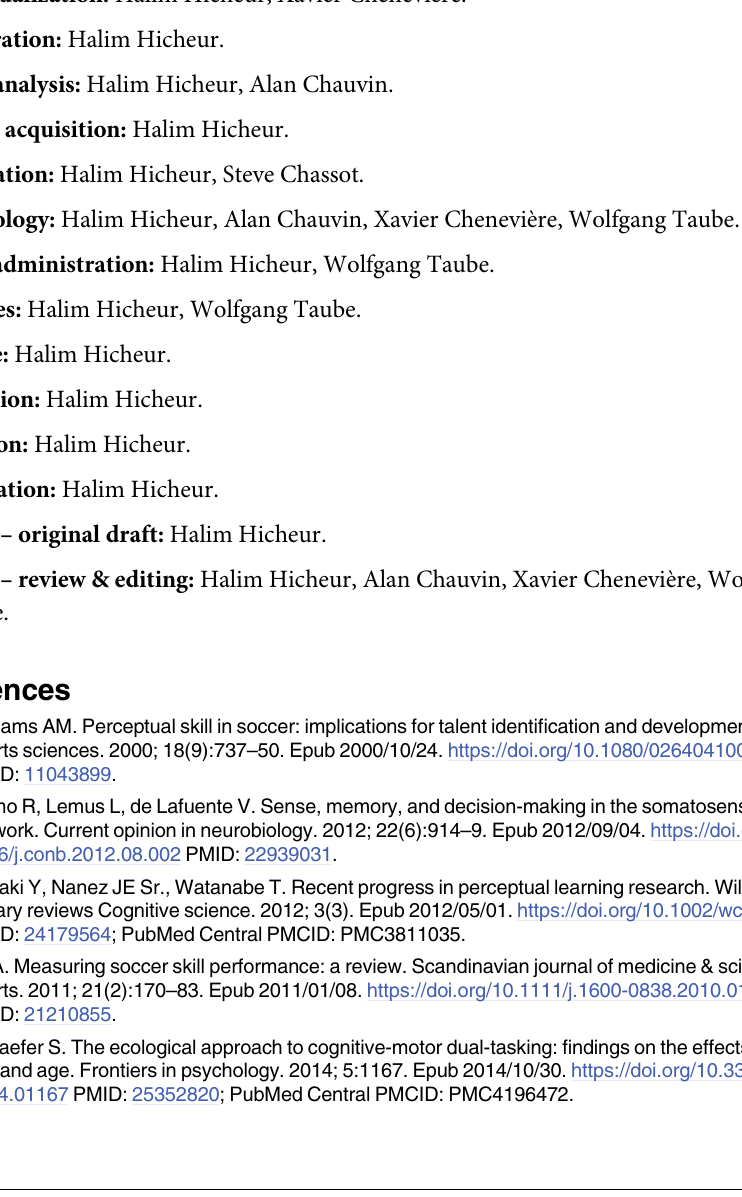
Passing spatial error of elite young soccer players. Figure B: Passing speed of elite young soccer players. Figure C: Response times of elite young soccer players. Figure D: Passing accuracy scores measured by the Cognifoot system or judged by coaches. Figure E: Passing speed scores measured by the Cognifoot system or judged by coaches. Figure F: Reactiveness scores mea- sured by the Cognifoot system or judged by